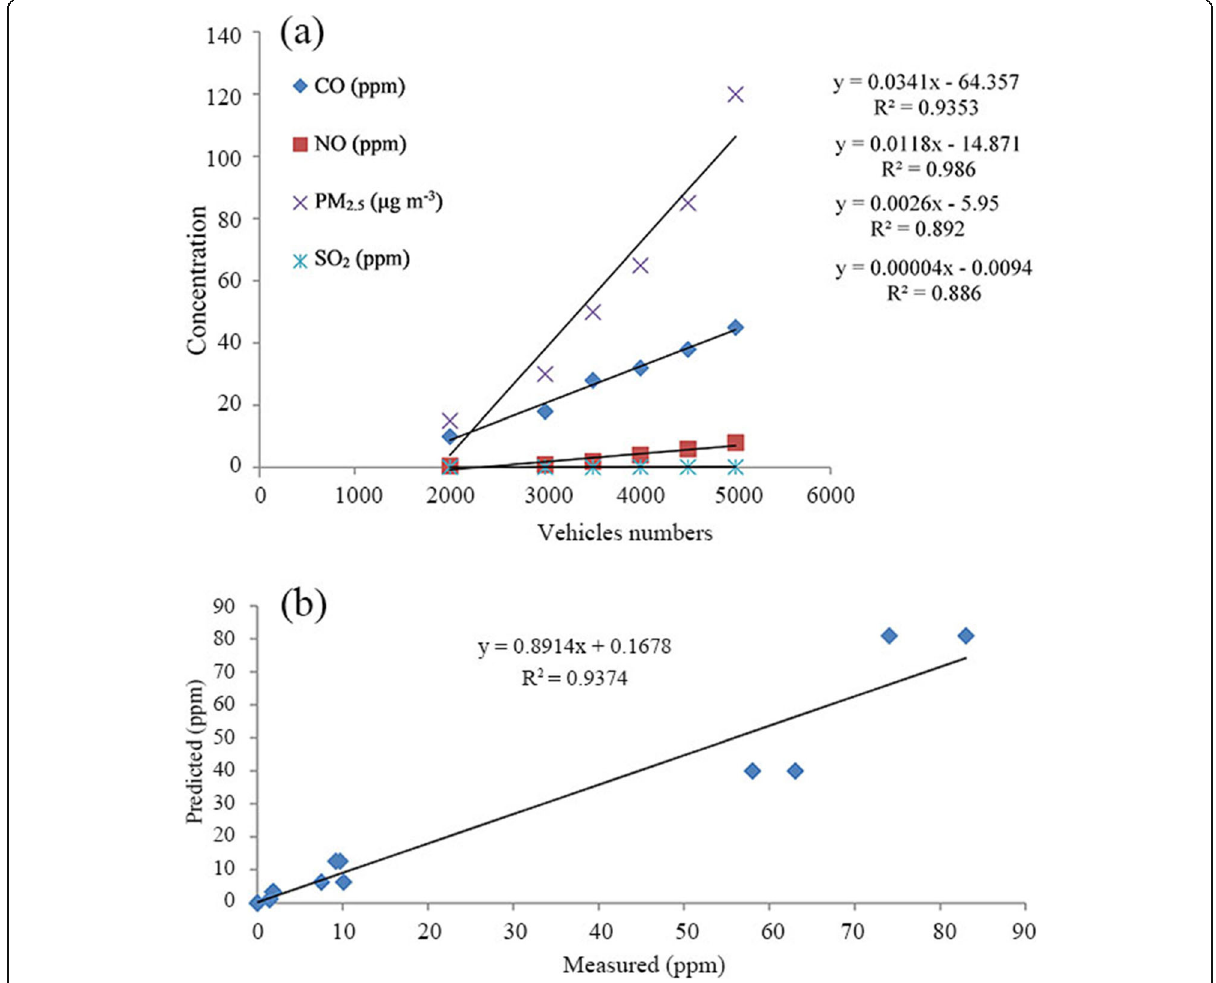
Fig. 12 a Exhaust pollutant and vehicle numbers; b correlation coefficient of